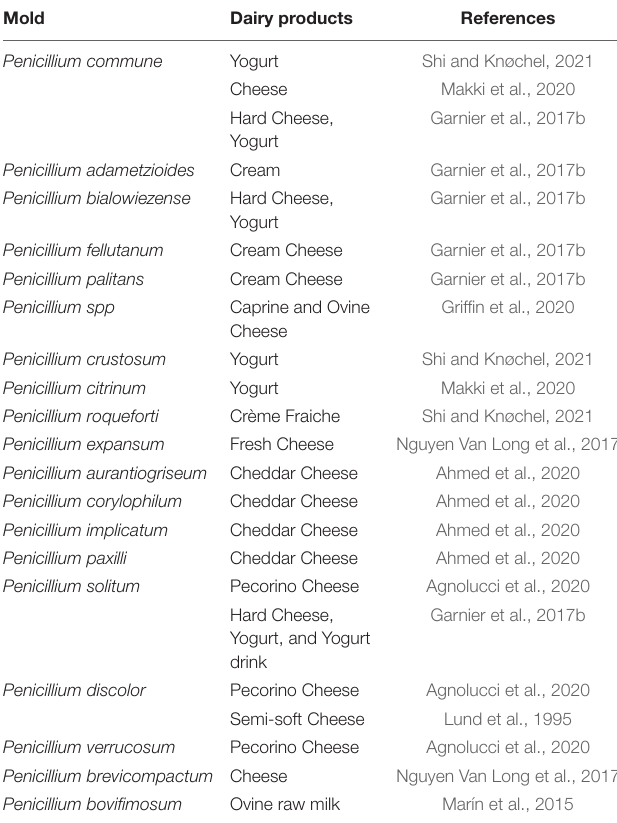
TABLE 1 | Diversity of spoilage Penicillium strains isolated from contaminated dairy